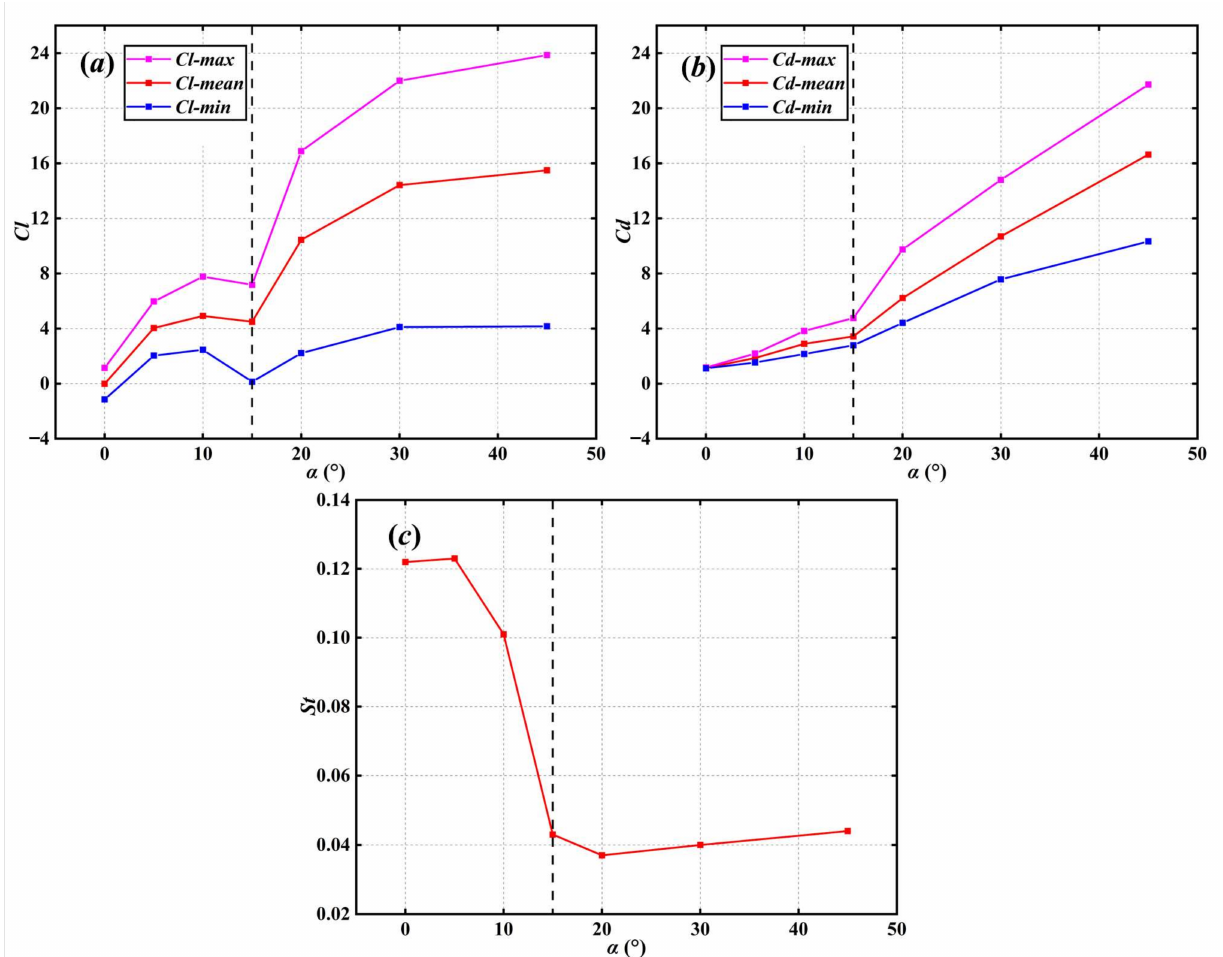
Figure 8. Time-average ( a ) lift coefficient, ( b ) drag coefficient, and ( c ) Strouhal number at different AoAs.